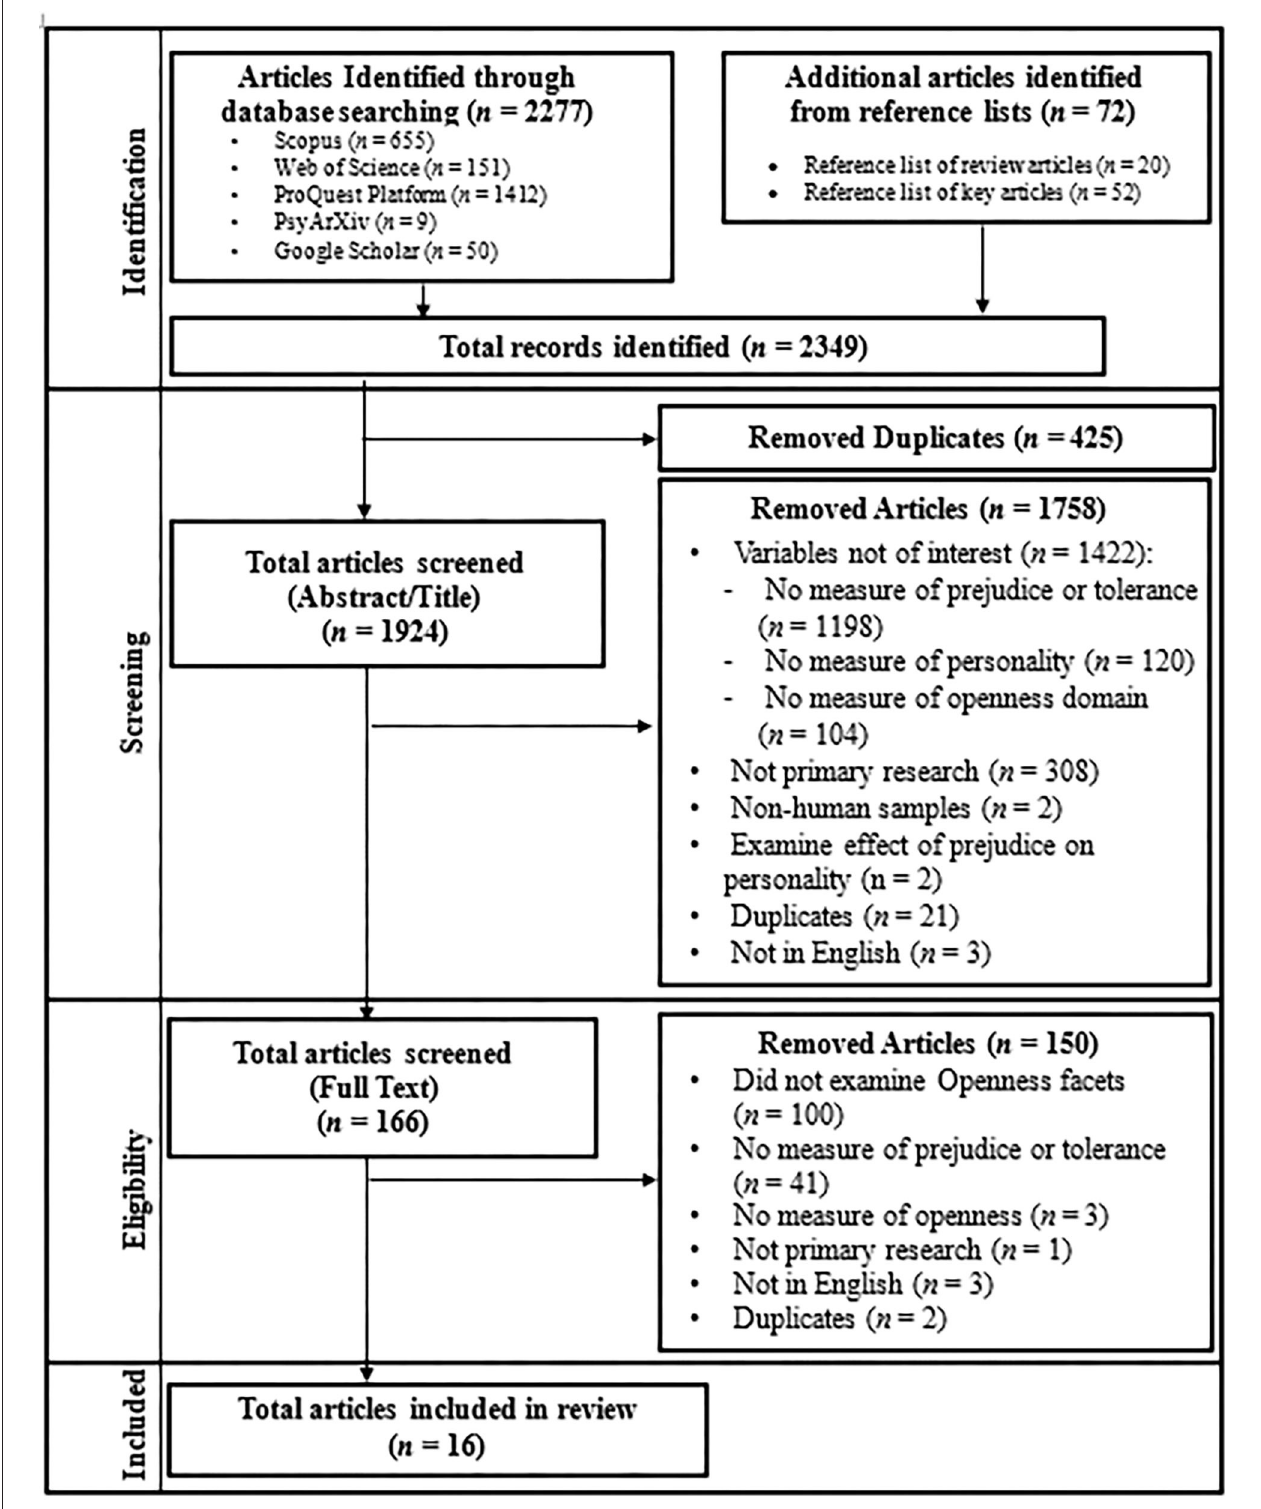
FIGURE 2 | Screening and inclusion decision flowchart of scoping review with meta-analysis.